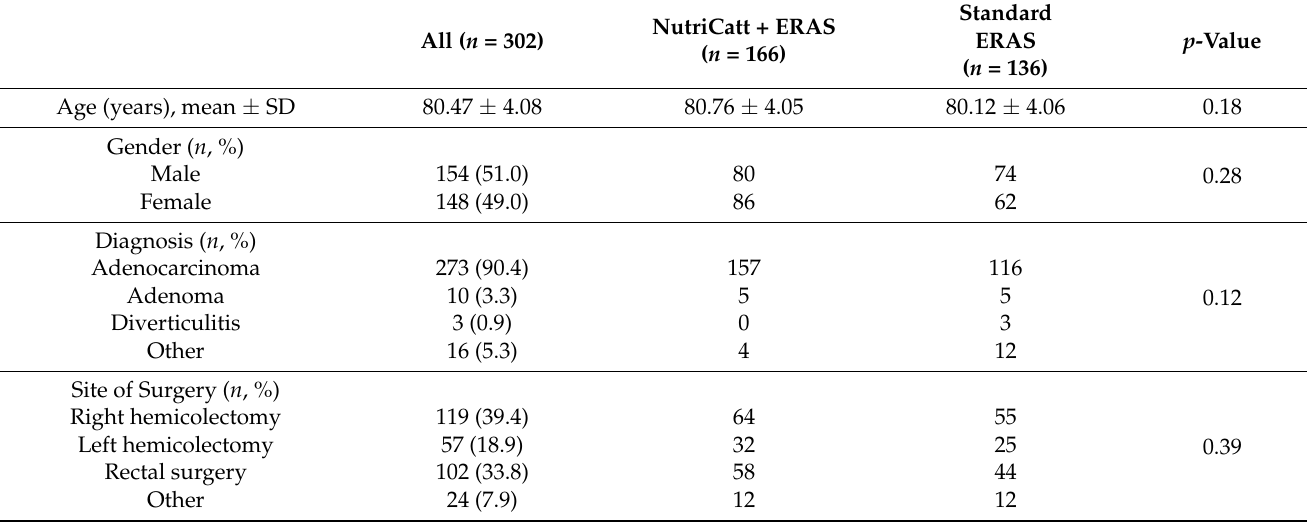
Table 1. Patient characteristics.